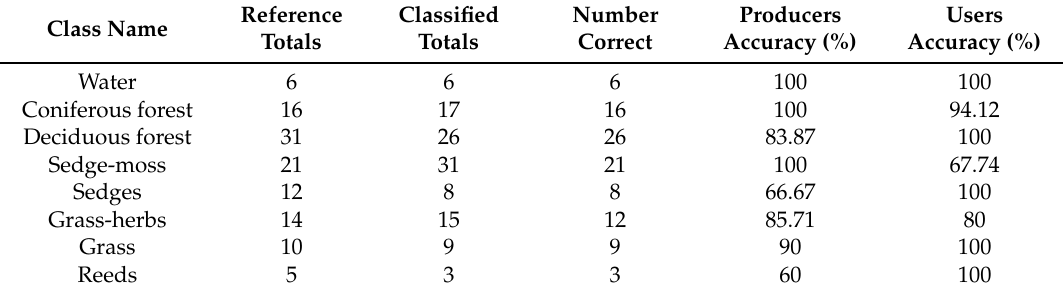
Table 3. Accuracy totals for each class.